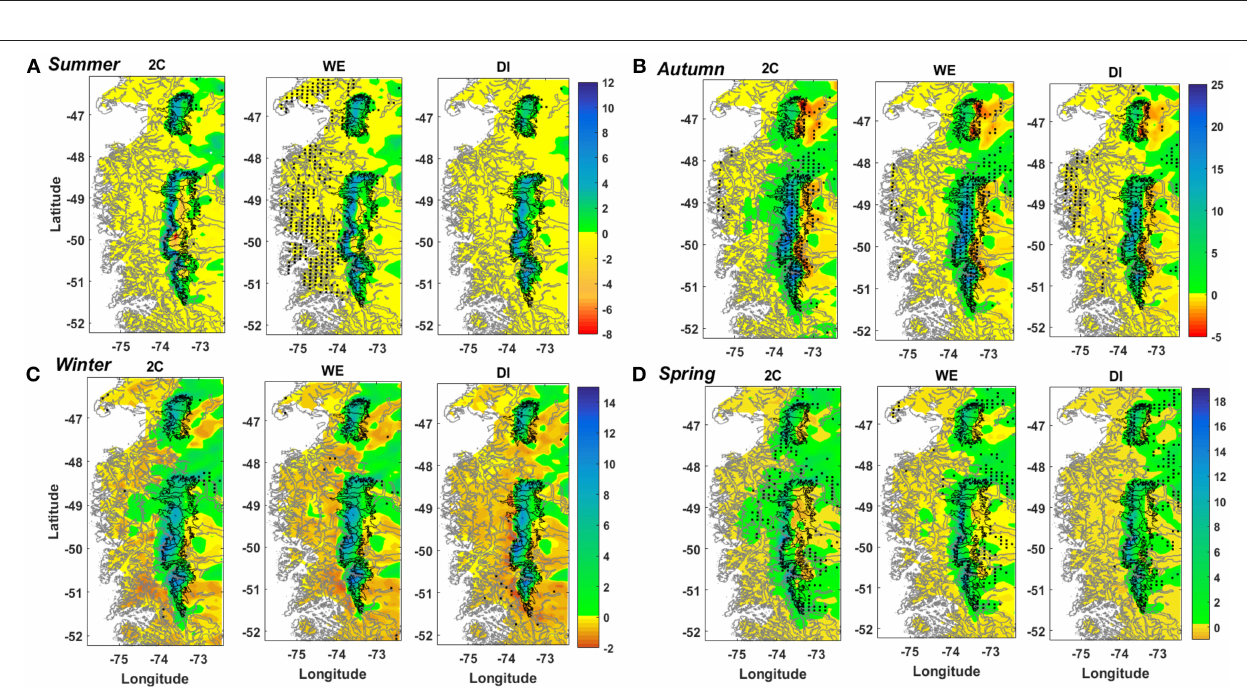
FIGURE 4 | Annual cycle of snow accumulation for the sub-regions of both Patagonia Icefields. (A) 2C, (B) WE, (C) SC, (D) DI.